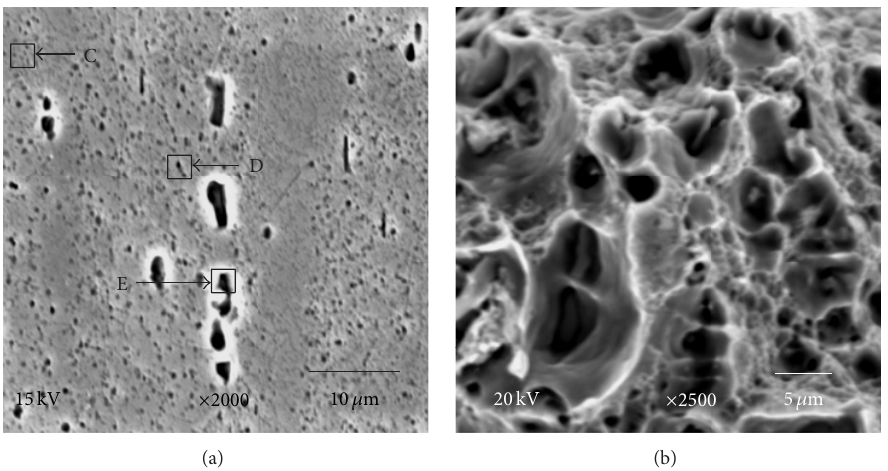
Figure 1: (a) Microstructure and (b) fractography of the investigated aluminium alloy.